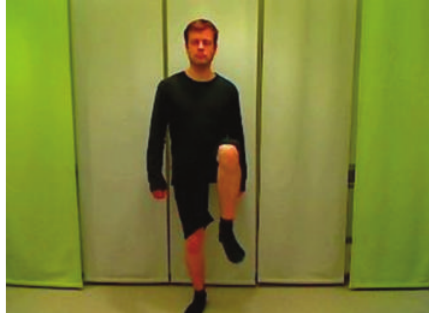
Figure 1: A screenshot of the exercise video showing the instructor performing a demonstration